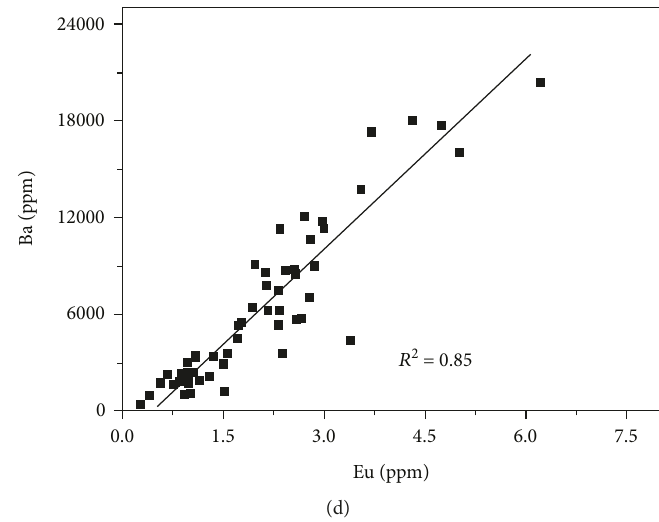
Figure 5: The plots showing Ba and Eu contents in samples of this study. (a) Concentrations of Ba and Eu in mudrock and chert for Batch 1. A linear correlation with an R 2 of 0.88 is observed. (b) Concentrations of Ba and Eu in carbonate rocks for Batch 1. No linear correlation is observed. (c) Concentrations of Ba and Eu in mudrock and chert for Batch 2. A linear correlation with an R 2 of 0.86 is observed. (d) Concentrations of Ba and Eu in mudrock and chert for Batch 1 and Batch 2. A linear Ba-Eu correlation with an R 2 of 0.85 is